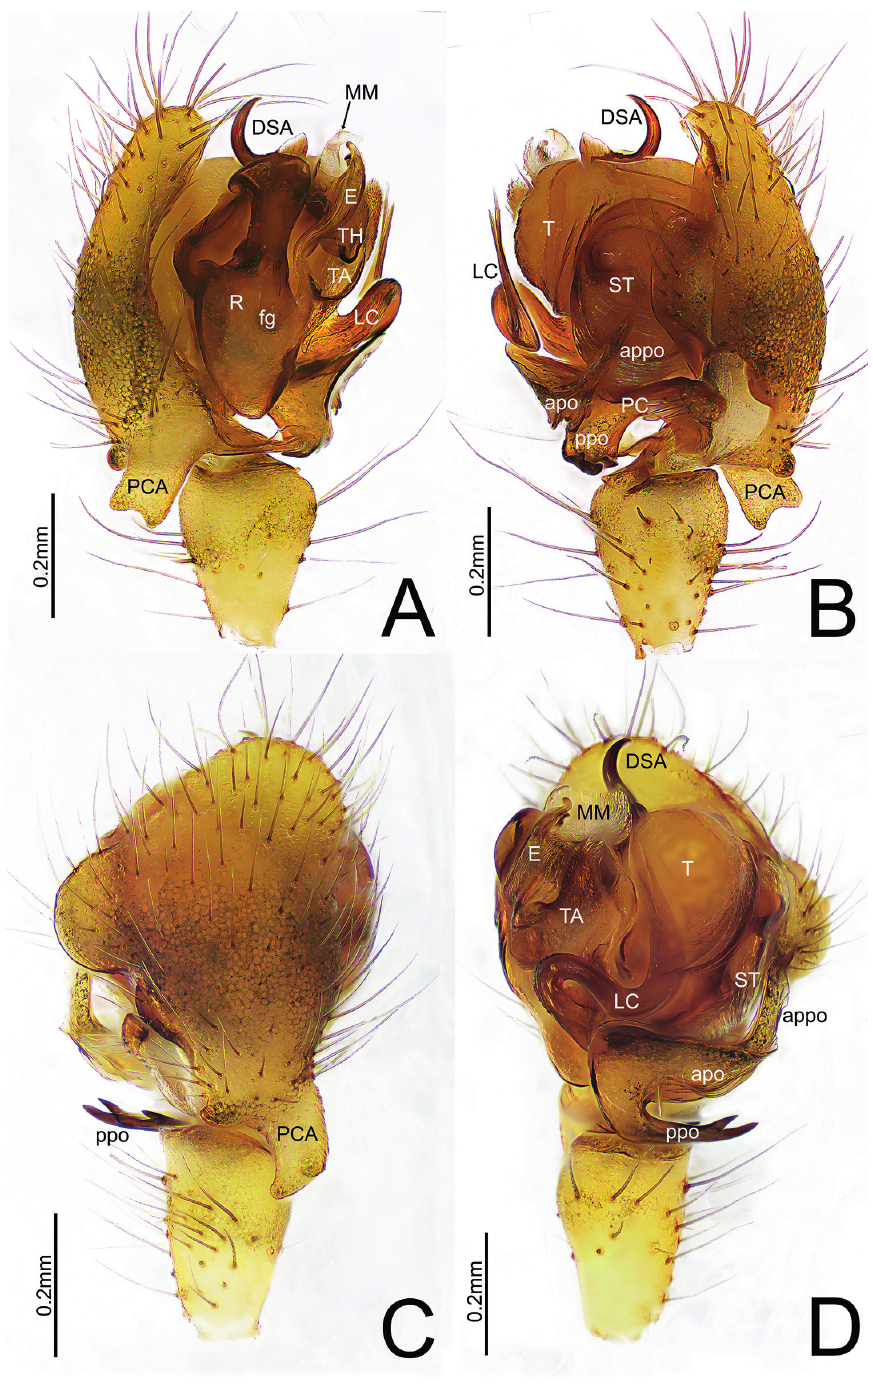
Figure 4. Himalaphantes lingulatus sp. nov., holotype ♂ A palp, prolateral view B palp, retrolateral view C palp, dorsal view D palp, ventral